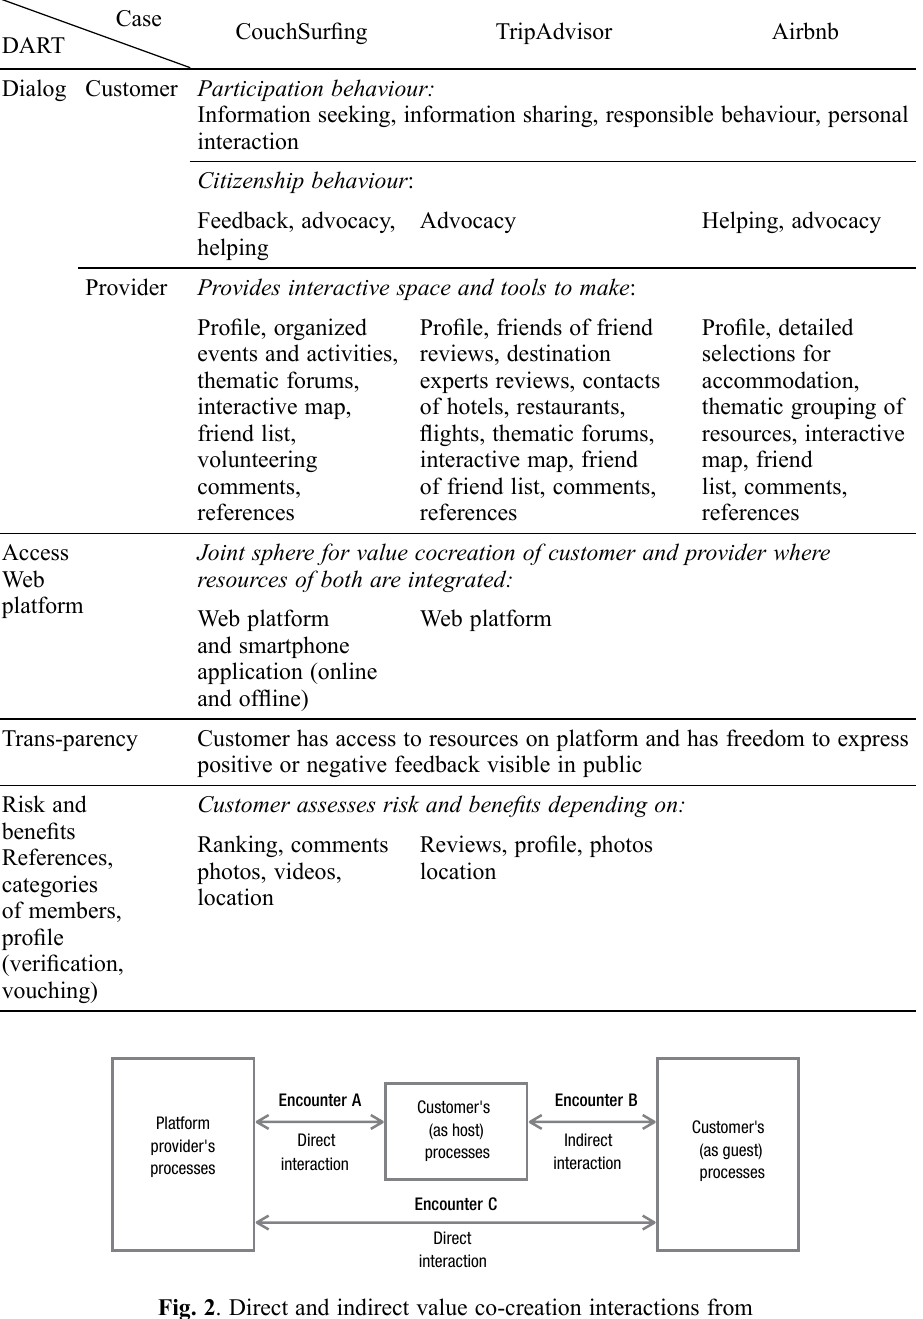
Fig. 2 . Direct and indirect value co-creation interactions from the perspective of a provider (based on case